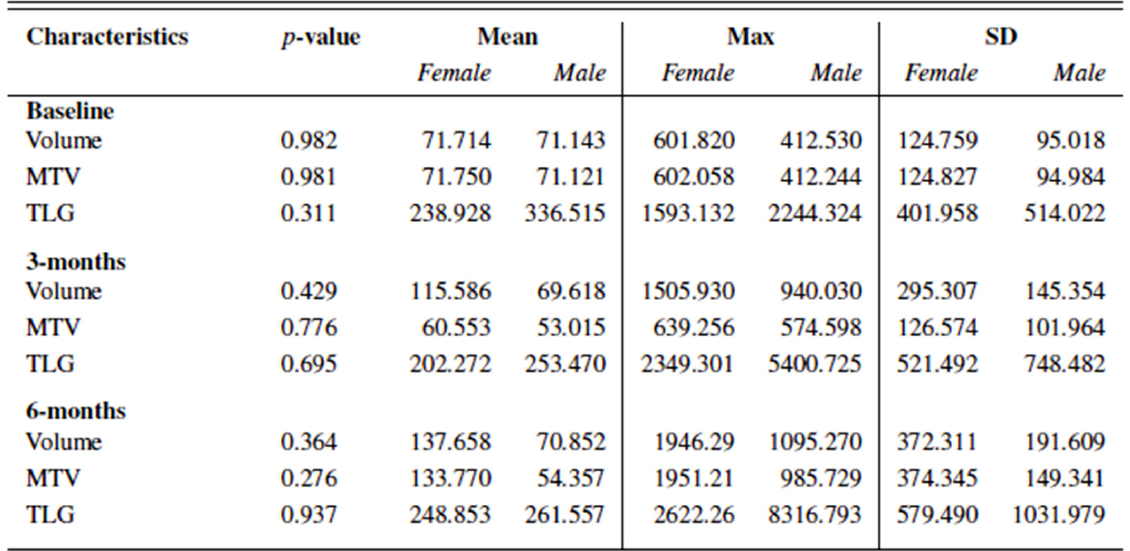
Figure 5. Total tumor load (volume in ml) and total metabolic tumor load (metabolic tumor volume MTV and total lesion glycolysis TLG) at baseline, and three and six months after initiation of ICI in female and male patients with advanced melanoma. treatment (n = 64 men, 86.49%), while nearly one out of two women (n = 13, 44.83%) showed progressive disease under treatment ( p = 0.001). Figure 6.